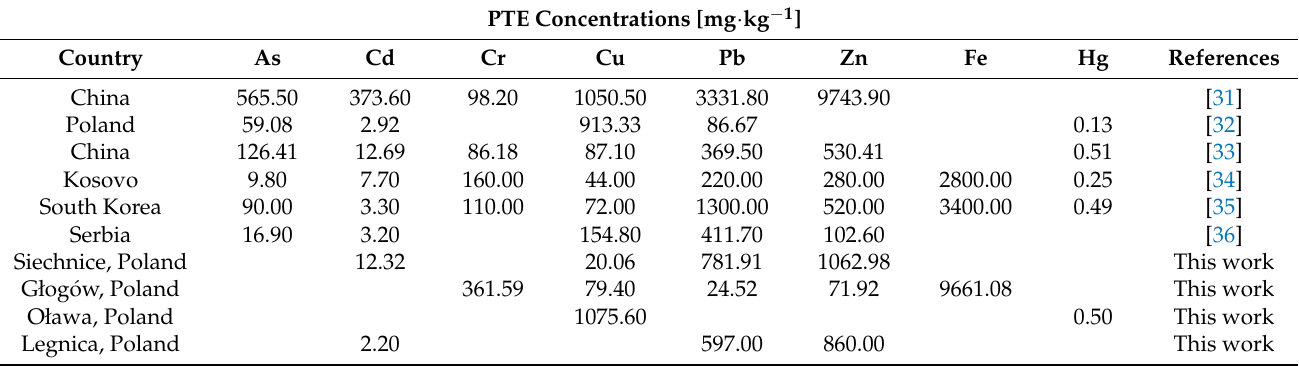
Table 3. PTEs concentrations in other